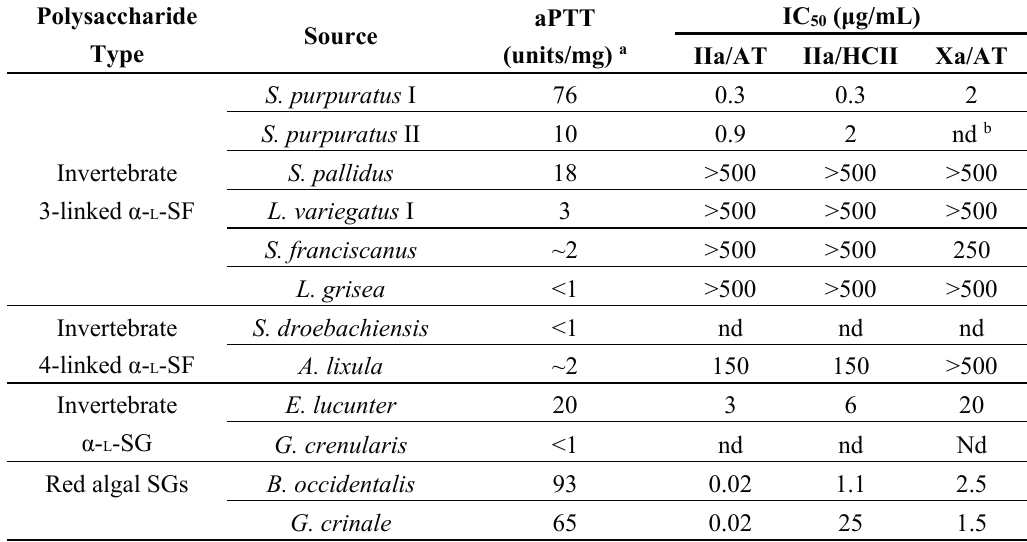
Table 2. Anticoagulant activities of marine sulfated glycans of well-defined structures (Figure 2) measured by activated partial thromboplastin time (aPTT) and by IC 50 values of thrombin (IIa) and factor Xa inhibition in the presence of antithrombin (AT) or heparin cofactor II